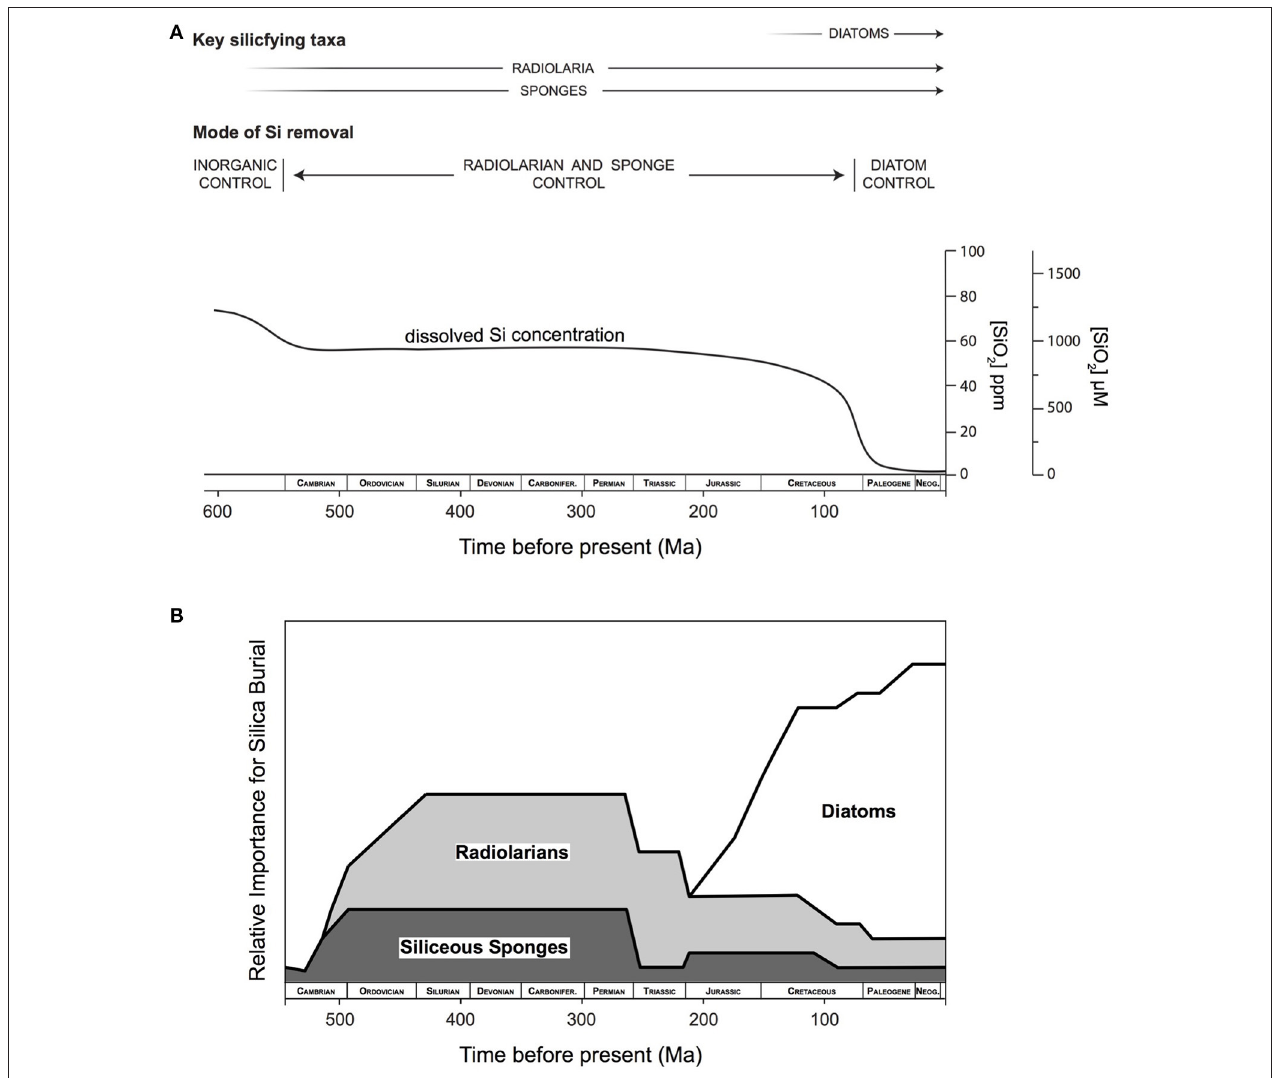
FIGURE 1 | The evolution of the oceanic Si cycle in the geologic record from the latest Precambrian to the present envisioned by Siever (1991). (A) In the absence of biosilicifiers dissolved Si (DSi) concentrations were determined by inorganic reactions with respect to amorphous silica solubility and/or with other Si-bearing phases. With the appearance of sponges and radiolarians in the early Phanerozoic biomineralization caused drawdown of DSi concentrations. However, DSi was rapidly reduced with the evolution and diversification of diatoms during the Cenozoic time period. From Schneider and Boston (1991) by permission of The MIT Press. (B) Qualitative interpretation of the relative role of the importance of radiolarians, sponges and diatoms present in the fossil record though geologic time (Redrawn from Kidder and Erwin, 2001). Reproduced with permission © 2001, The University of Chicago